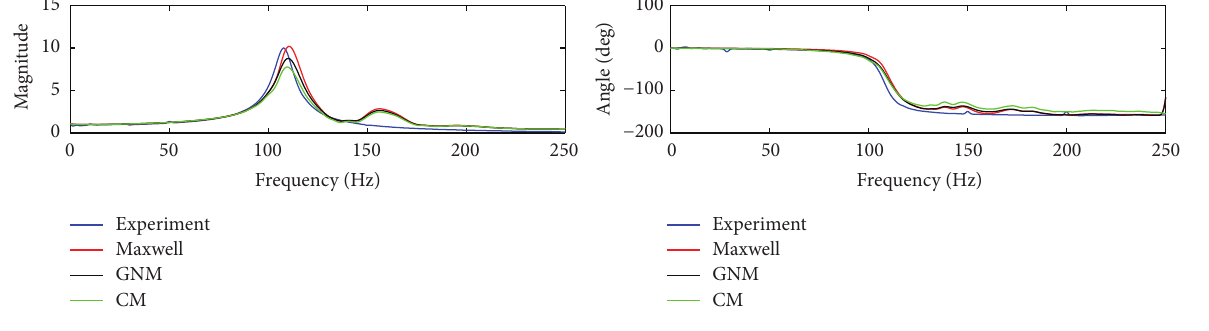
Figure 11: Force transmissibility